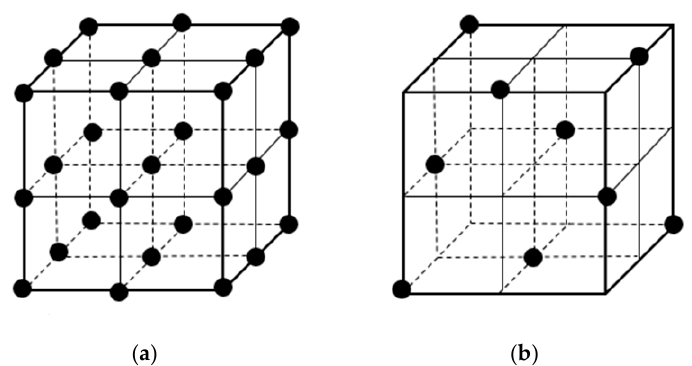
Figure 2. A four-factor layout: ( a ) comprehensive test; ( b ) orthogonal experimental design.